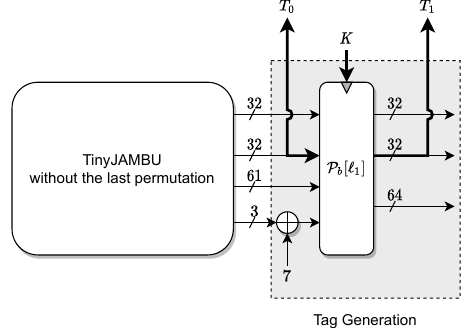
Figure 2: Linear hull for TinyJAMBU. Masks on normal lines are all-zero, while those on thick lines are